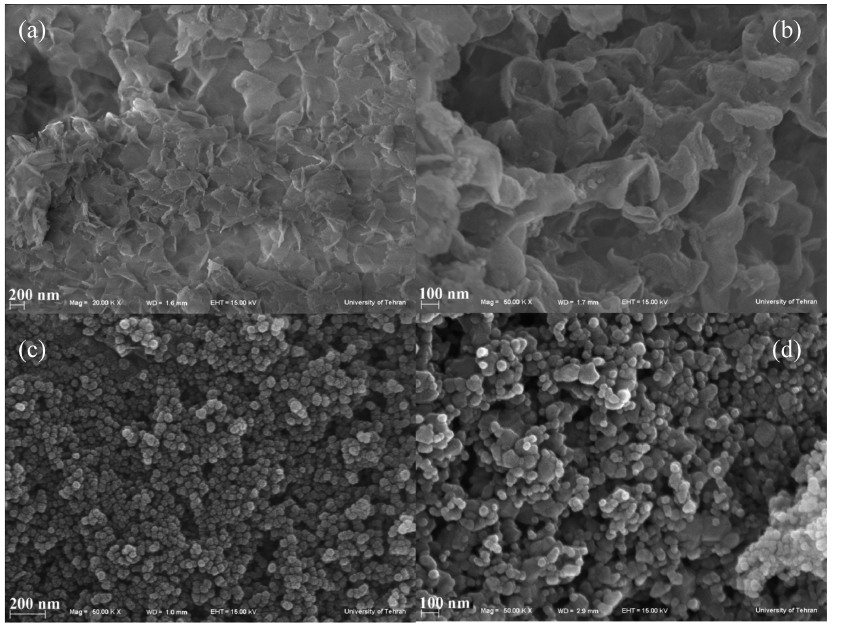
Figure 5: SEM images (a) hydrothermal reaction in pH = 8, (b) a after calcinations, (c) hydrothermal reaction in pH = 9, and (d) after calcinations.